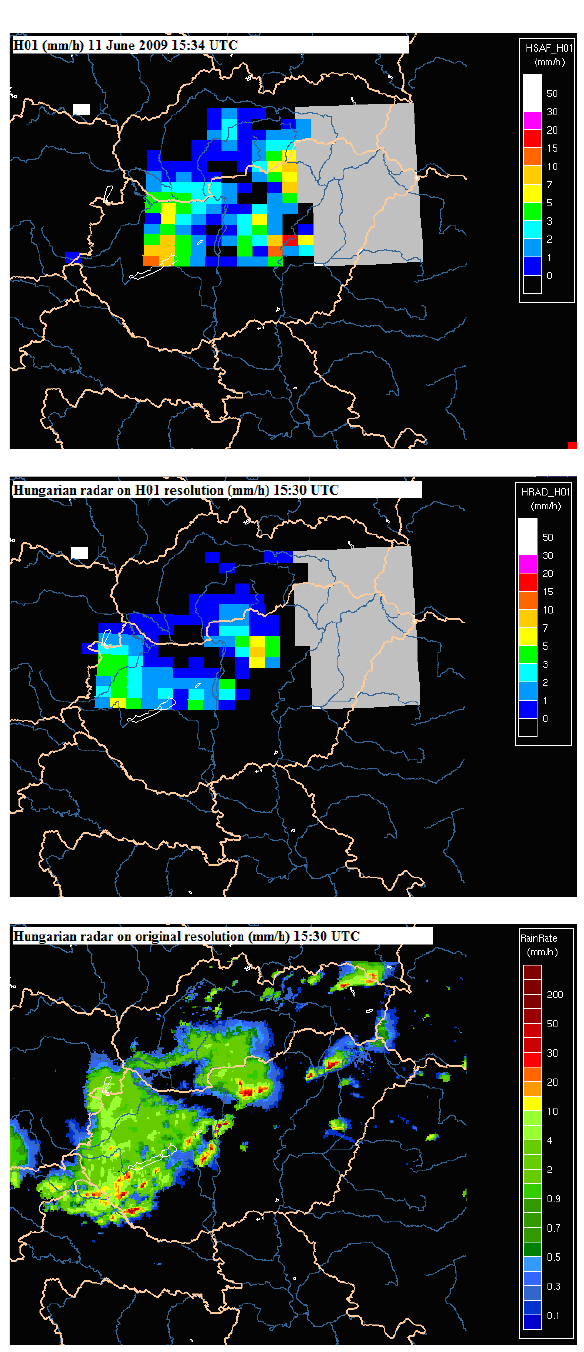
Fig. 9. Precipitation rate map of PR-OBS-1 (top), precipitation rate Fig.9: Precipitation rate map of PR-OBS-1 (top), precipitation rate map from the Hungarian radar 1474 map from the Hungarian radar network up-scaled at the PR-OBS-1 network up-scaled at the PR-OBS-1 grid resolution (centre), Hungarian radar map at its original 1475 grid resolution (centre), Hungarian radar map at its original reso- resolution (bottom) of 11 June 2009 at 15:30 UTC. We can see that the radar rain intensities up-1476 lution (bottom) of 11 June 2009 at 15:30UTC. We can see that the radar rain intensities up-scaled onto satellite grids are smoothed and the convective cells are aggregated. The PR-OBS-1 detects the con- vective spots well, even though an intensity overestimation and false alarms are observed in the southeastern part. Note that the grey area is a no-data area not covered by the satellite